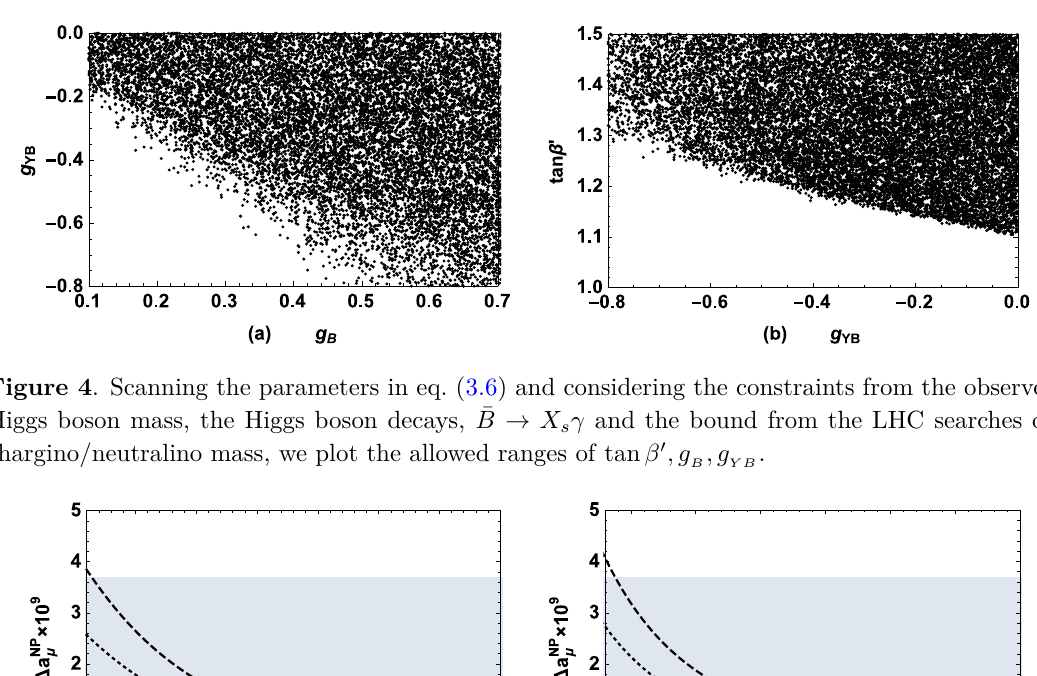
Figure 5 . ∆ a NP versus m 0 is plotted for M E = 1 TeV (a), where the gray area denotes the µ experimental 2 σ interval, the solid, dotted, dashed lines denote the numerical results for tan β = 10 , 20 , 30 respectively. Similarly, ∆ a NP versus M E is plotted for m 0 = 0 . 8 TeV (b). µ